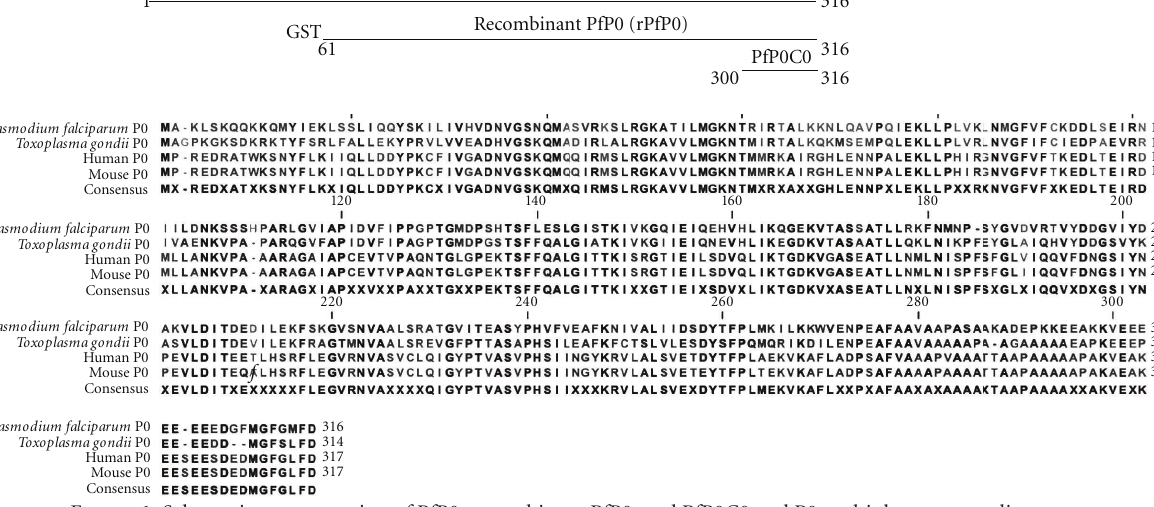
Figure 1: Schematic representation of PfP0, recombinant PfP0, and PfP0C0 and P0 multiple sequence alignment. in vitro and in vivo [15, 18, 19]. When we attempted to raise monoclonal antibodies (mAbs) against the major fragment of PfP0, recombinant PfP0 (rPfP0, 61 − 316 amino acids),